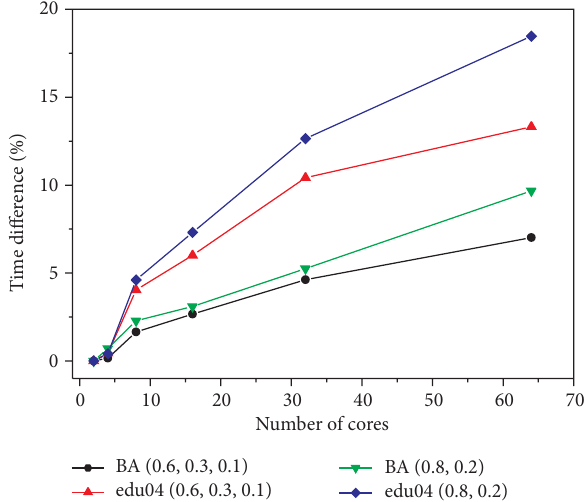
Figure 1: Relation between time difference and number of